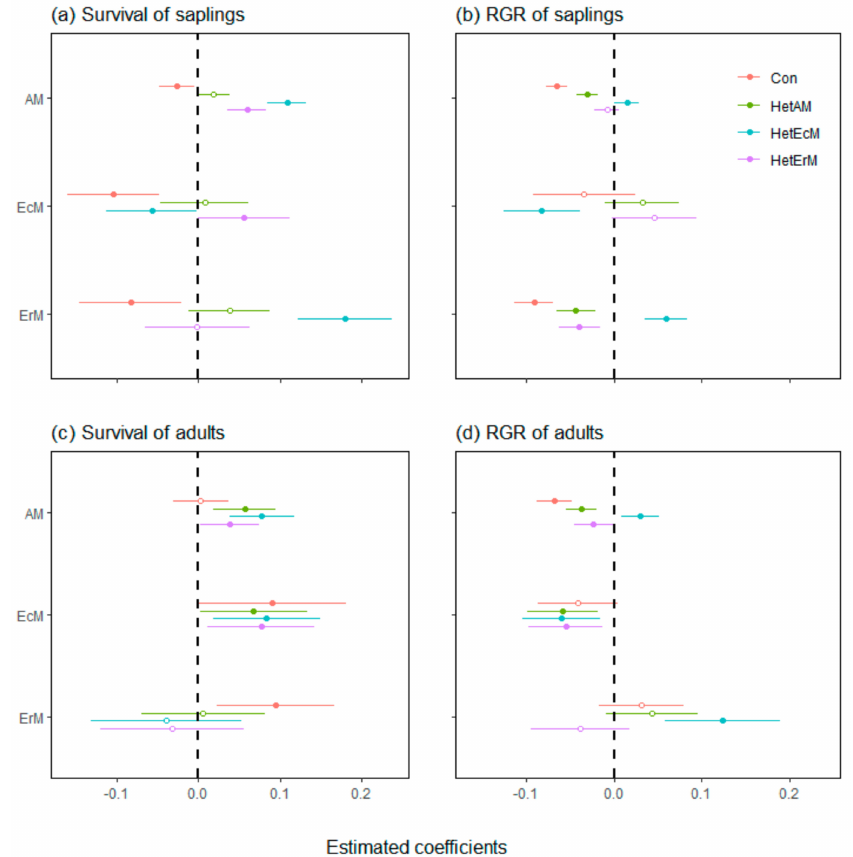
Figure 3. Estimated effects ( ± 2SE) of neighborhood factors on survival and RGR of species mycor- rhizal types at the sapling and adult tree life stages. Solid circles indicate significant effects ( p < 0.05), while open circles indicate non-significant effects. RGR, relative growth rates; Con, conspecific den- sity; HetAM, heterospecific AM density; HetEcM, heterospecific EcM density; HetErM, heterospecific ErM